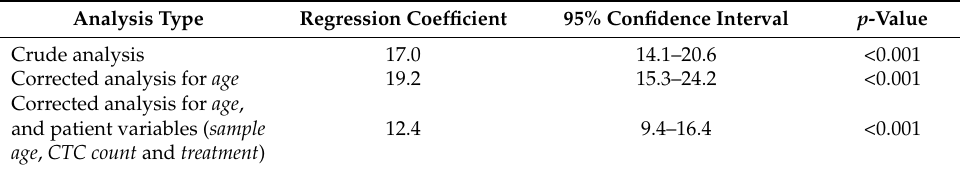
Table 1. Multiple regression analysis for association between sample type and nucleated events corrected for several patient